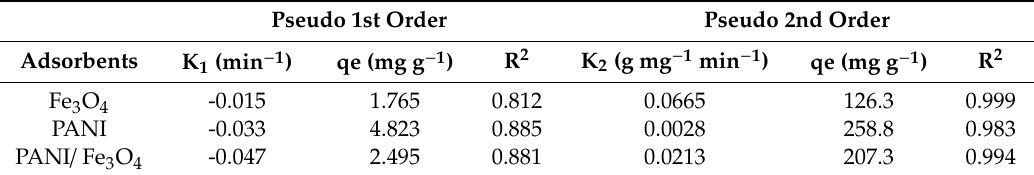
Table 3. Kinetics parameters for adsorption of AB40 on Fe 3 O 4 , PANI and PANI / Fe 3 O 4 composite based on pseudo-first-order and pseudo-second-order